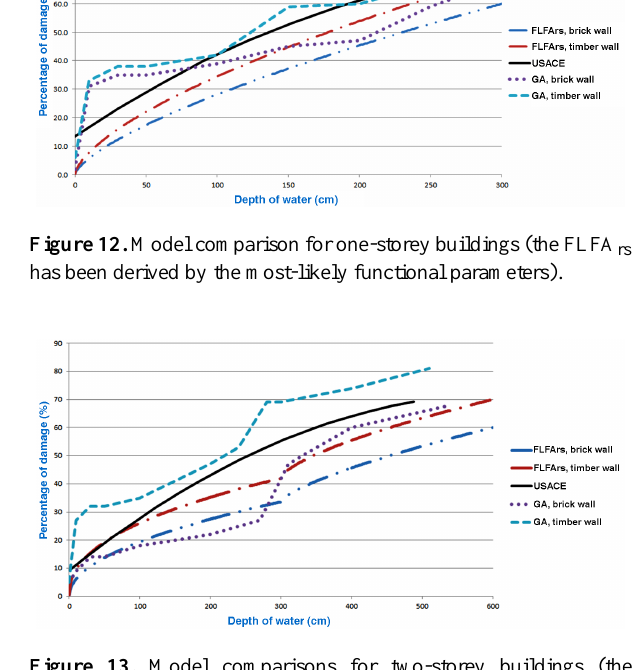
Figure 13. Model comparisons for two-storey buildings (the FLFA rs has been derived by the most-likely functional